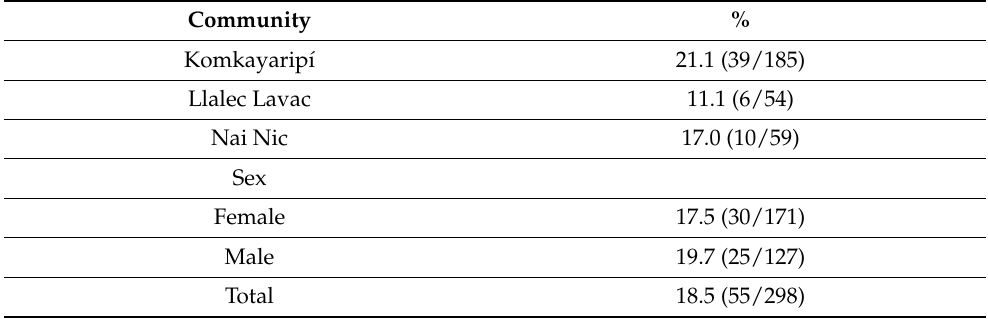
Table 1. Frequency of seropositivity for Chagas by communities and sex. Indigenous communities of the southern Chaco